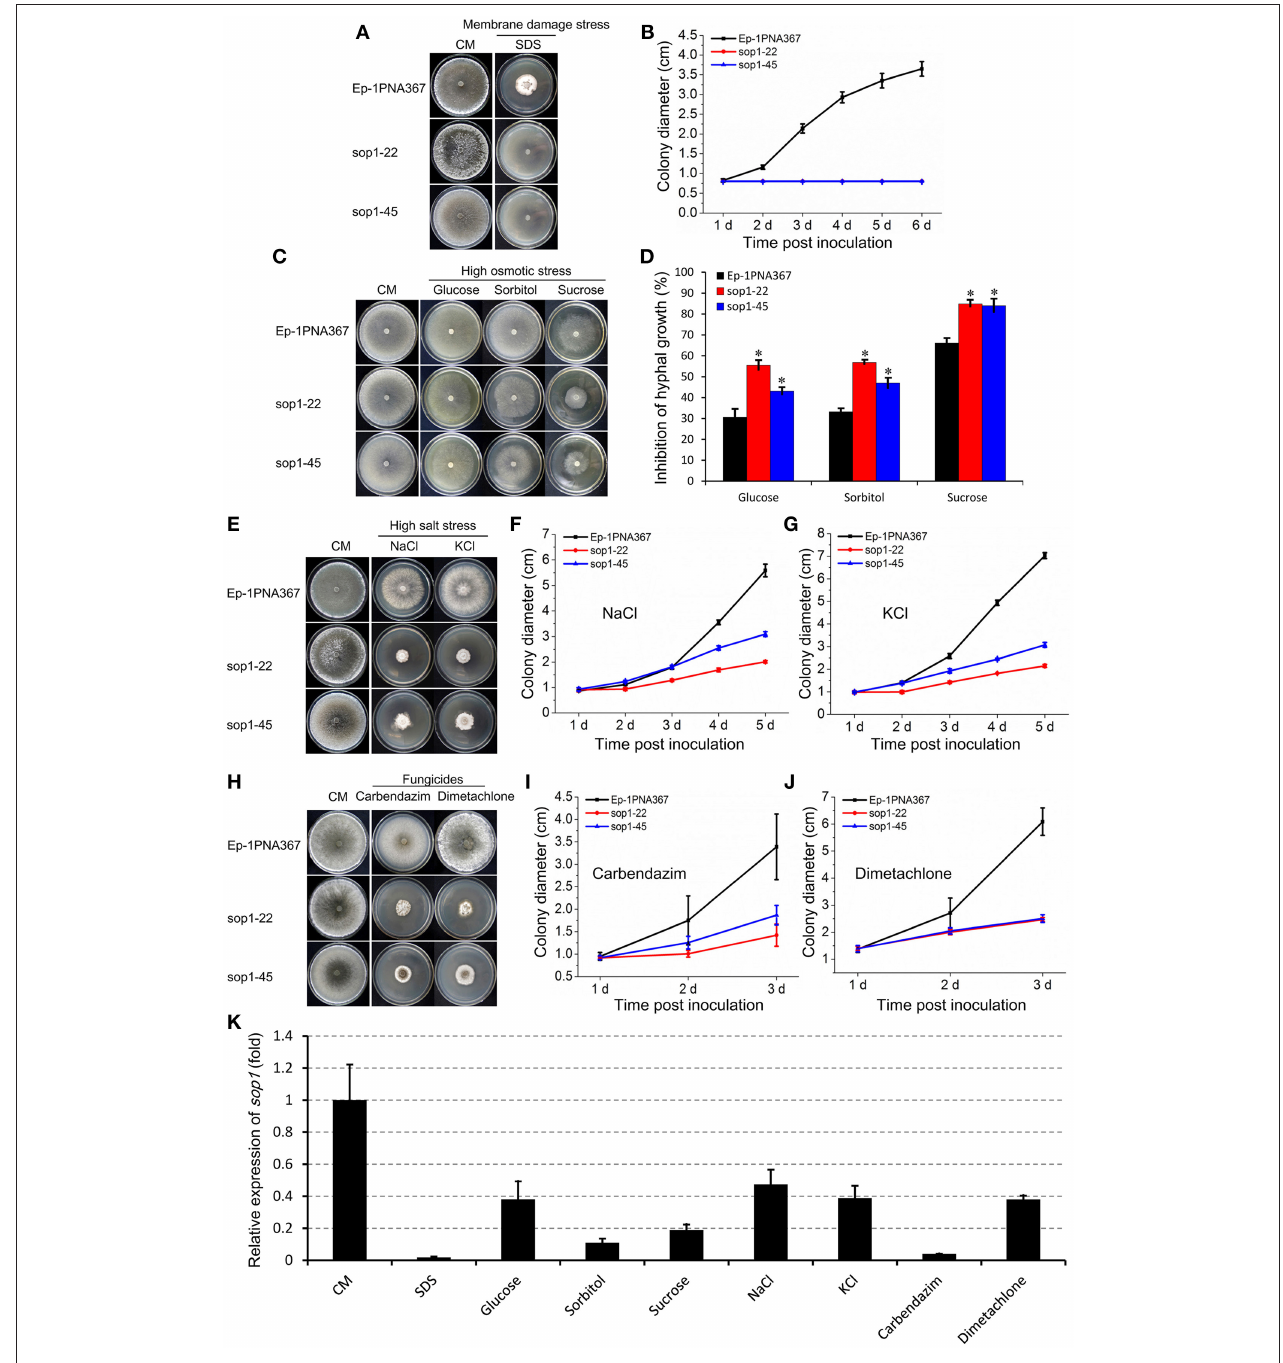
FIGURE 4 | Growth of sop1 silenced transformants in the presence of various stressors. (A) Phenotypes of the sop1 RNAi-silenced transformants and the wild-type strain grown on CM supplemented with 0.02% SDS at 20 ◦ C. Photos were taken at 6 dpi. (B) The colony diameter of the sop1 RNAi-silenced transformants and the wild-type strain on CM supplemented with 0.02% SDS at different times. (C) Phenotypes of the sop1 RNAi-silenced transformants and the wild-type strain that grown on CM supplemented with glucose (1 M), sorbitol (1 M), and sucrose (1.2 M), respectively, at 20 ◦ C. Photos were taken at 3 dpi. (D) The inhibition rate of the hyphal growth of the sop1 RNAi-silenced transformants and the wild-type strain on stress-inducing media. * on the graph indicate significant differences, P = 0 .05. (E) Phenotypes of the sop1 RNAi-silenced transformants and the wild-type strain grown on CM supplemented with NaCl (1 M) and KCl (1 M), respectively, at 20 ◦ C. Photos were taken at 6 dpi. (F,G) The colony diameter of the sop1 RNAi-silenced transformants and the wild-type strain on CM supplemented with 1M NaCl and 1M KCl, respectively, at different times. (H) Phenotypes of the sop1 RNAi-silenced transformants and the wild-type strain grown on CM supplemented with carbendazim (0.25 µ g/mL) and dimetachlone (0.40 µ g/mL), respectively, at 20 ◦ C. Photos were taken at 6 dpi. (I,J) The colony diameter of the sop1 RNAi-silenced